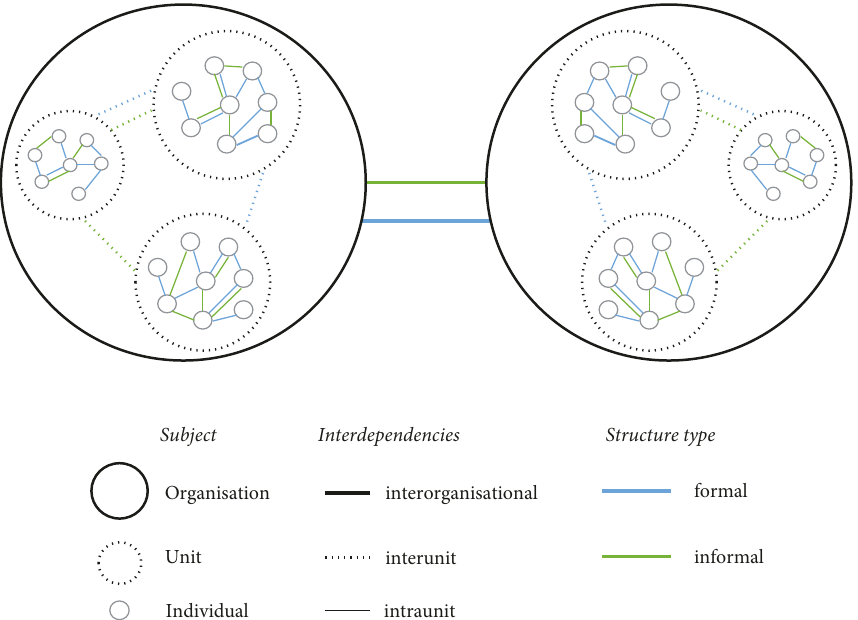
Figure 2: Overview of nested multilevel